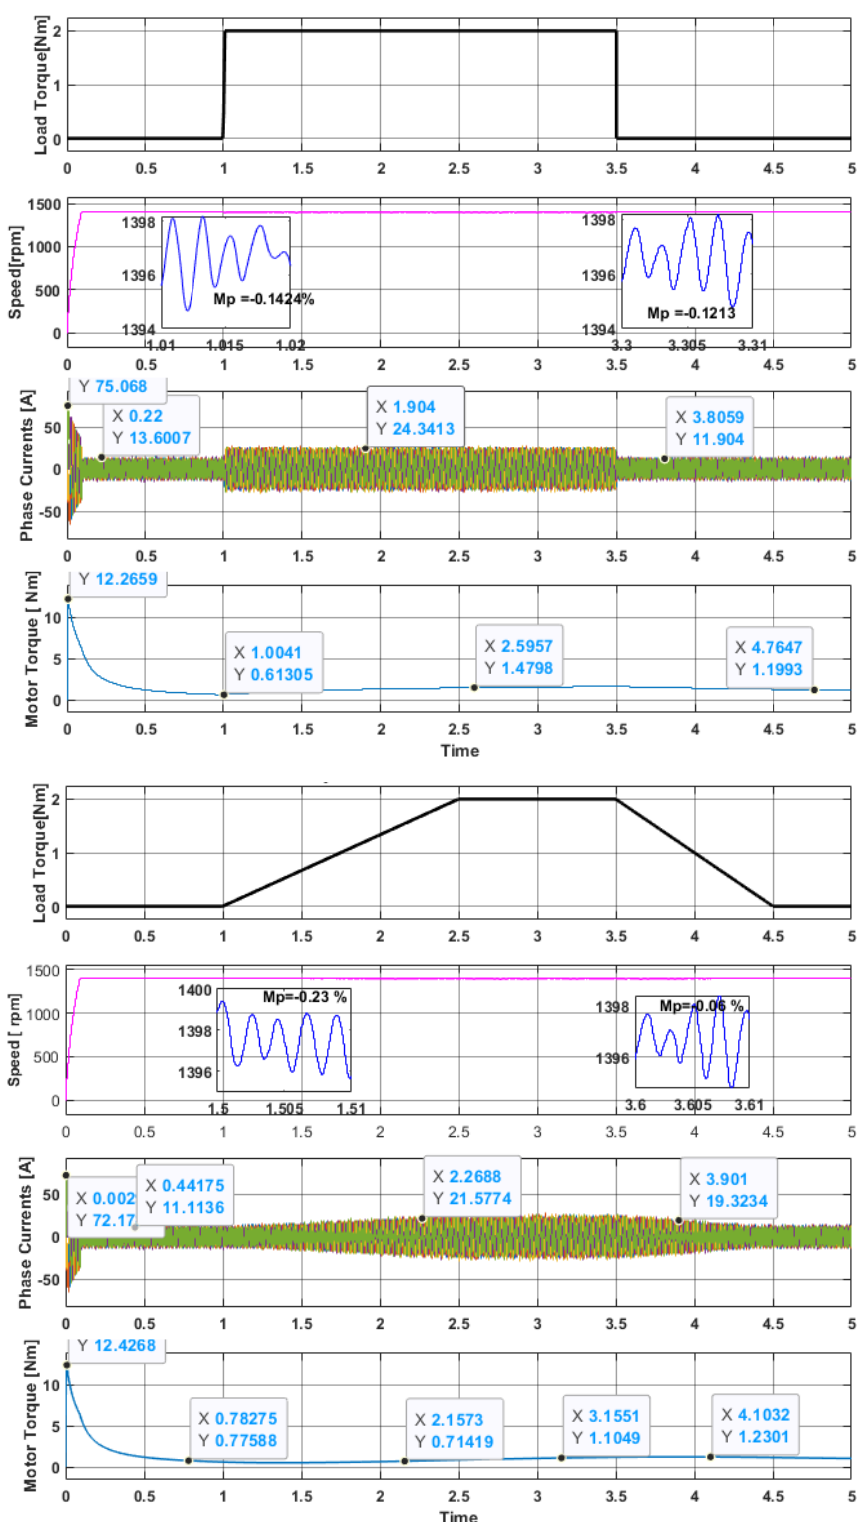
Figure 7. Transient performance of the drive with a fuzzy controller.